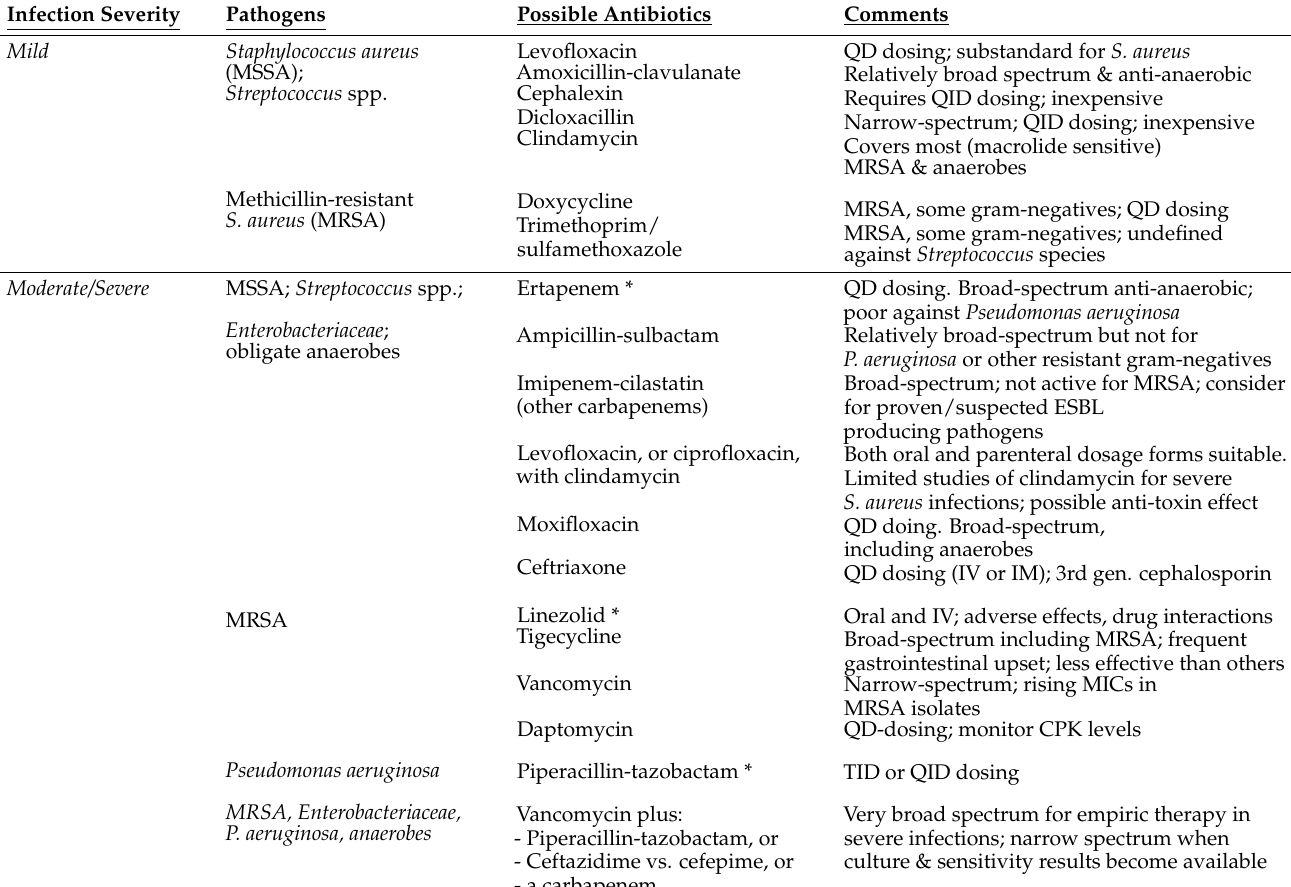
Table 1. Antibiotic agents to consider for treating diabetic foot osteomyelitis based on oral bioavailability and bone concentration (based on references